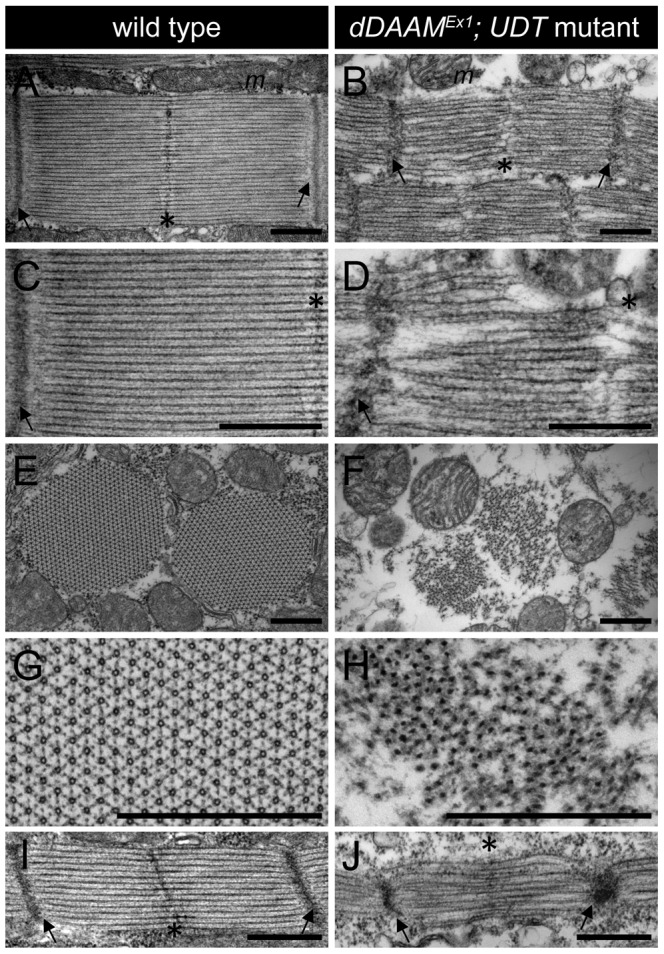
EM analysis of IFM morphology in dDAAM mutants.Electronmicrographs of IFM from wild type (A, C, E, G, I) and dDAAMEx1; UDT mutants (B, D, F, H, J). Longitudinal sections of adult IFM (A–D) show that, as compared to the wild type, highly ordered and tightly packed sarcomeres (A, C), the dDAAM mutant myofibrils (B, D) display Z-disc and M-band defects, and shortened sarcomeres with loosely organized thin and thick filaments. Transverse sections of wild type (E, G) muscles reveal the hexagonal lattice organization of thin and thick filaments, which is almost entirely lost in dDAAM mutant myofibrils (F, H). Instead, the mutant fibrils are irregularly shaped, consisting of clusters of thick filaments, and individual thin filaments are hardly detectable. Note: wild type thick filaments are hollow (G), while those of the dDAAM mutant are very dark, irregularly shaped and almost never hollow (H). Longitudinal sections of pupal IFM (48 hours APF) (I, J) show that, as compared to wild type (I), mutants (J) have strong Z-disc and M-line defects, shorter sarcomeres and irregular filament organisation. Arrows mark the Z-discs, asterisks mark the M-bands, m labels the mitochondria. Bars, 500 nm.